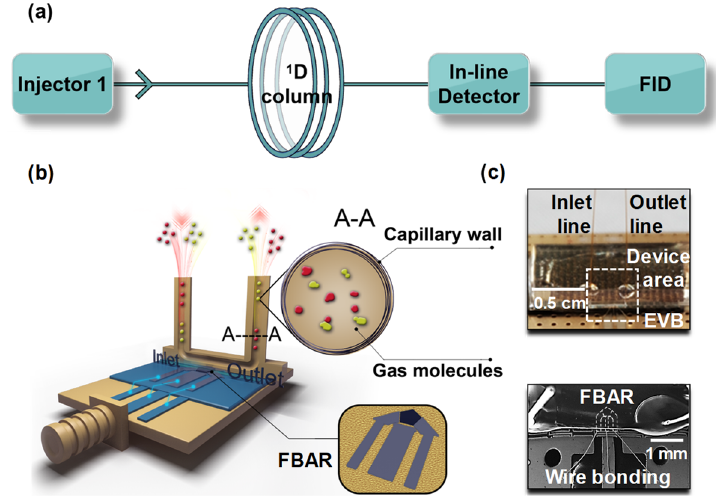
Figure 1. Simplified instrument configuration diagram showing the facilely hyphenated GC ( a ). ( b ) Cartoon showing the prototype microfluidic FBAR detector in a gas chromatography system. ( c ) The digital photo and scanning electron microscope picture showing the microfluidic FBAR detector.